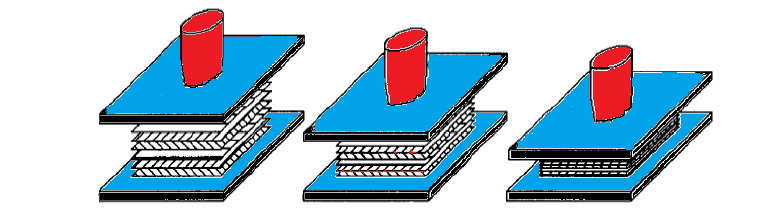
Figure 4. The schematic of a compression moulding